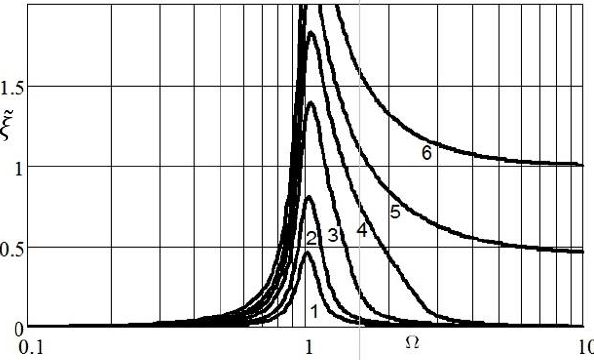
Figure 5. The normalized imaginary part of the wave number 𝜉̃ at different values of the parame- ter: 𝑚̃:1 − 𝑚̃ = 2; 2 − 𝑚̃ = 1; 3 − 𝑚̃ = 0.4; 4 − 𝑚̃ = 0.2; 5 − 𝑚̃ = 0.1; 6 − 𝑚̃ = 0.07.